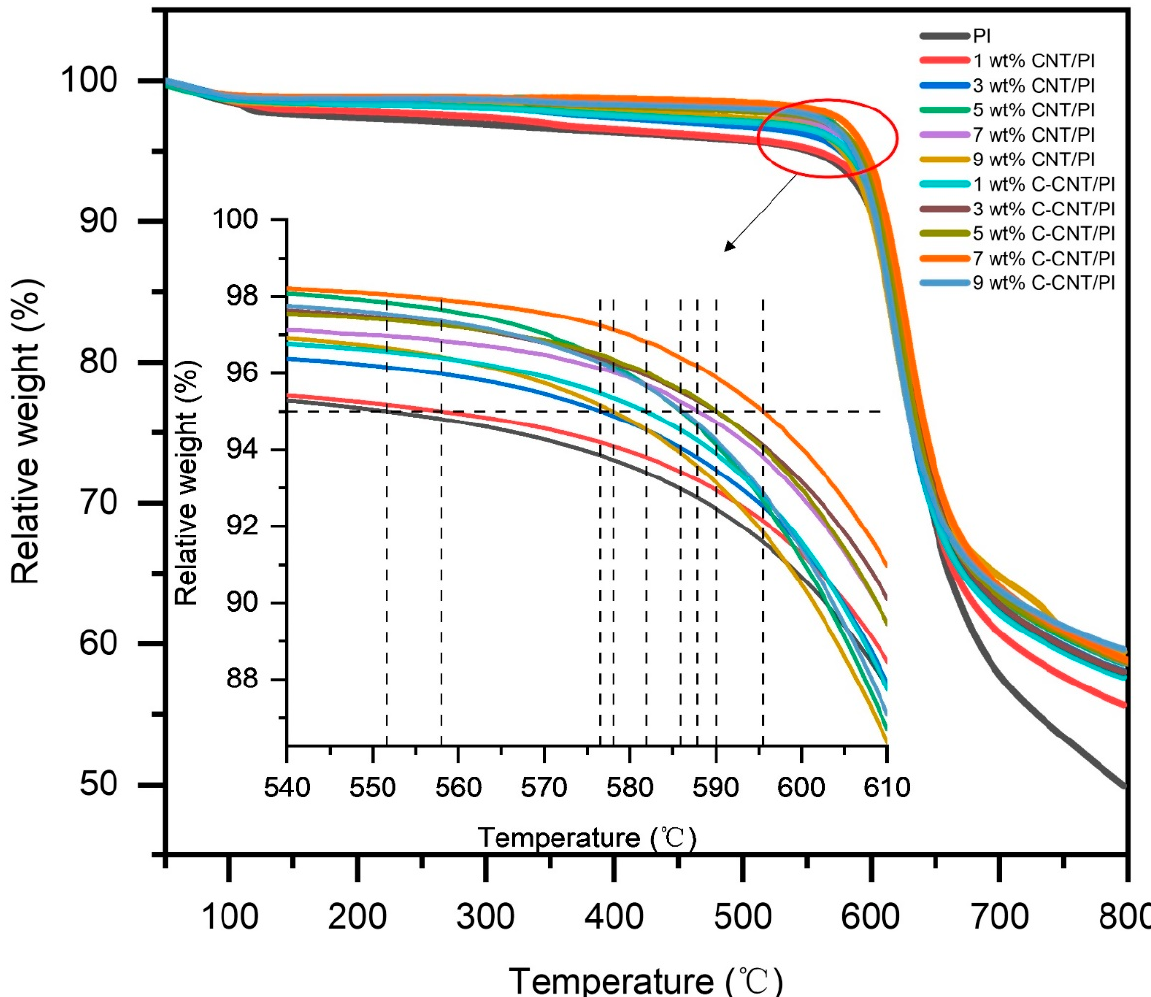
Figure 10. TGA results of PI films with different contents of CNT and C-CNT.